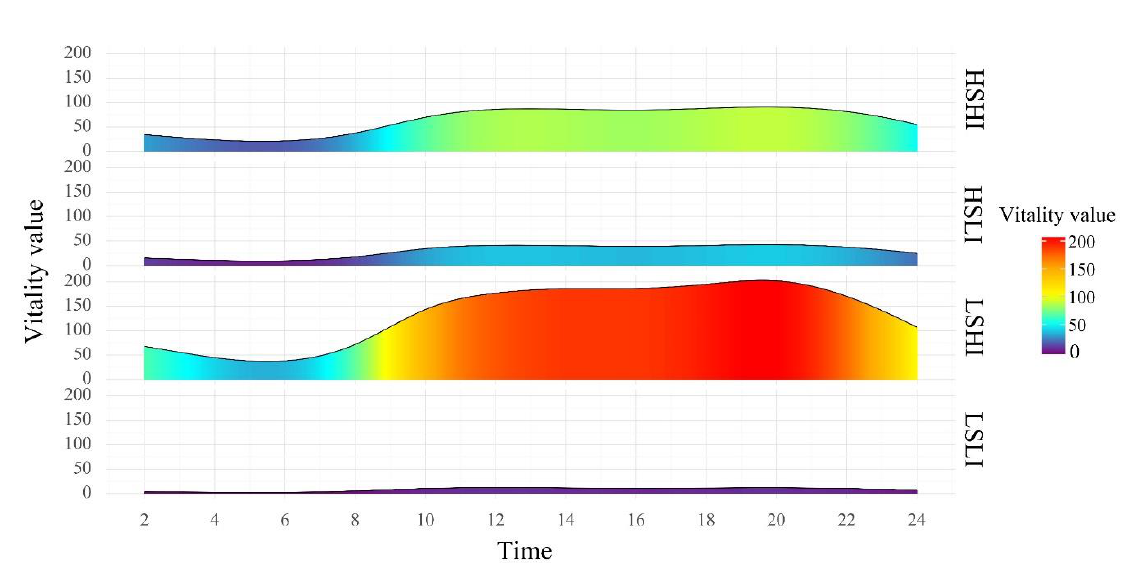
Figure 9. Temporal characteristics of street vitality types. ( a ) Weekdays; ( b ) Weekends.